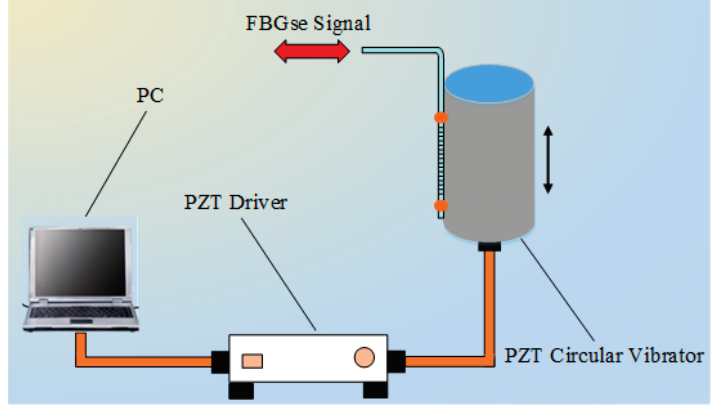
Figure 14. Schematic diagram of seFBG vibration signal generator.